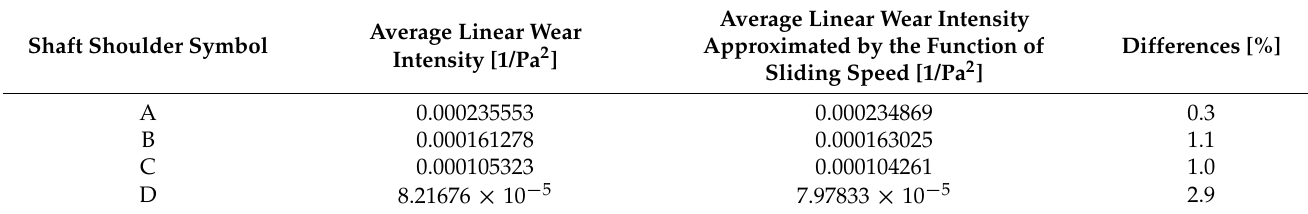
Table 14. The linear wear intensity values for the shaft shoulders.